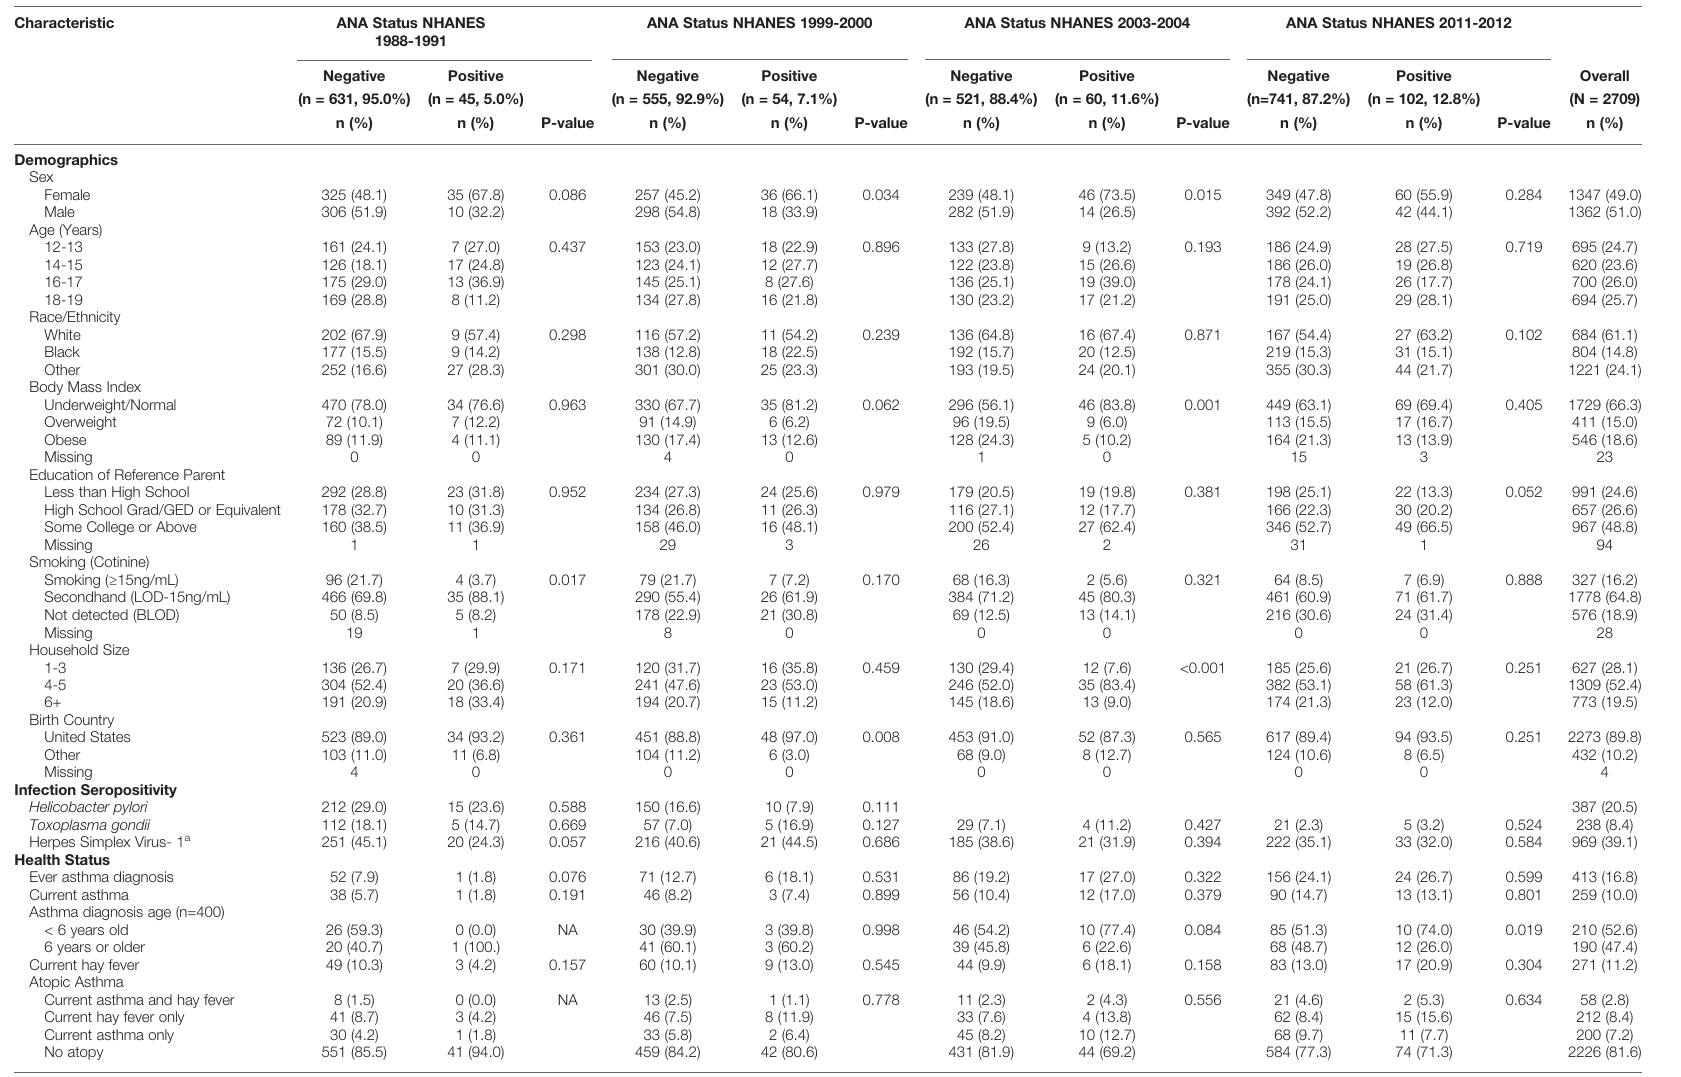
TABLE 1 | Participant Characteristic Counts and Weighted Proportions by Time Period and ANA Status in U.S. Adolescents.